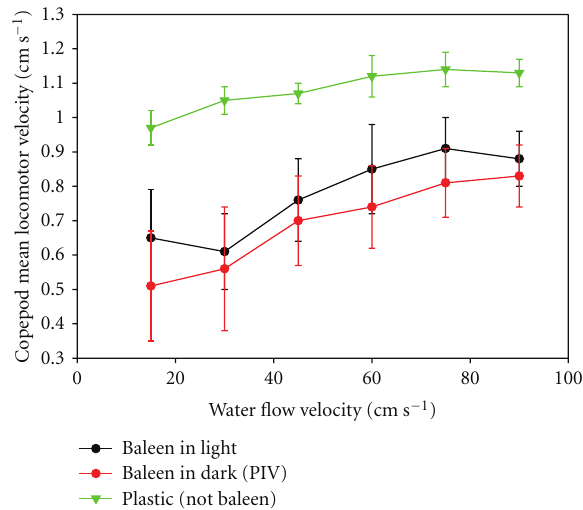
Figure 2: Copepod ( Calanus ) locomotor velocity (mean, N = 50; error bars = 1 SD) in flow tank, measured at distance = 10 cm from closest baleen, in light and dark (22 degrees C).